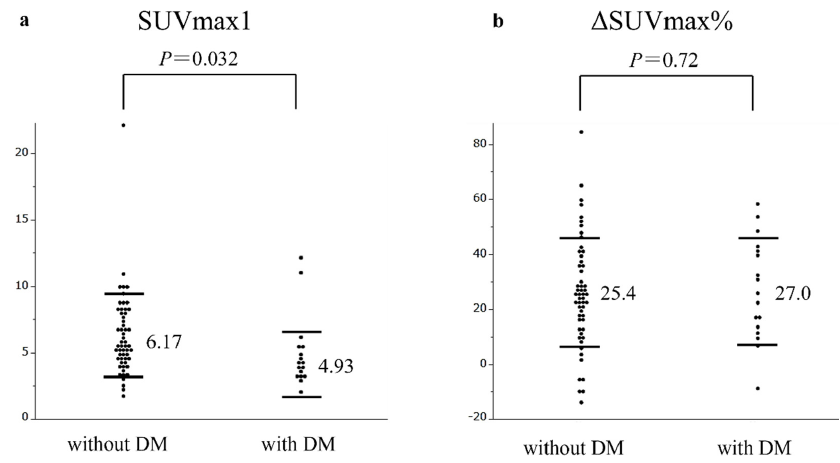
Figure 2. Comparison of SUVmax1 ( a ) and Δ SUVmax% ( b ) between patients with and without diabetes mellitus. ( a ) Patients with tumors showing without diabetes mellitus was significantly higher SUVmax1 than patients with tumor showing with diabetes mellitus ( P = 0.032). ( b ) Patients with tumors showing without diabetes mellitus was not higher Δ SUVmax% than patients with diabetes mellitus ( P = 0.72).